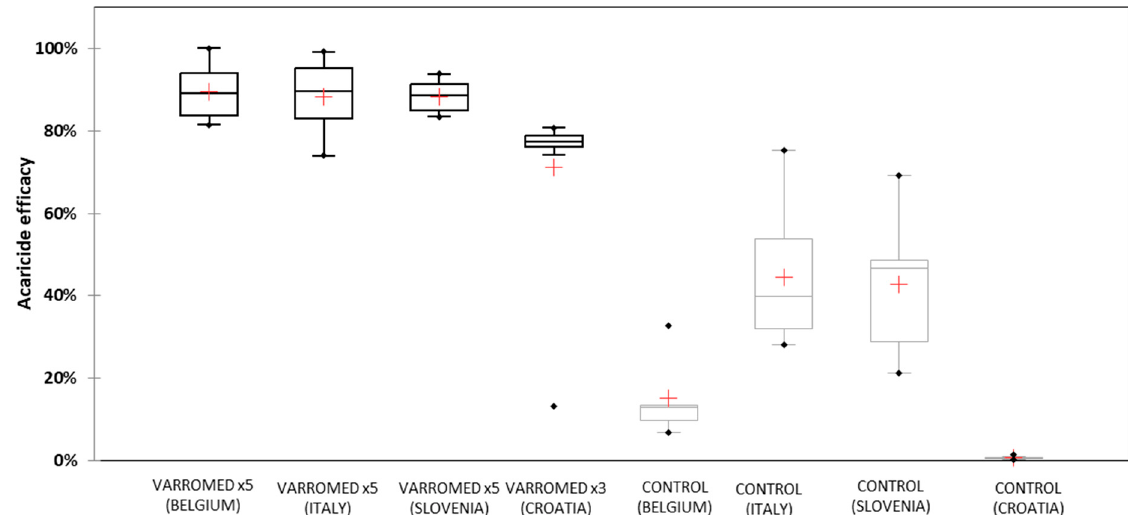
Figure 4. Box plot of acaricide efficacies recorded during the summer/autumn trial and relative mite fall during the same period in the control group (%). The horizontal line in boxes shows the median. The box shows the first and third quartile. Whiskers extend to 1.5 × interquartile range (IQR). Diamonds mark the outliers outside the 1.5 × IQR. Additionally, the pluses show mean values.